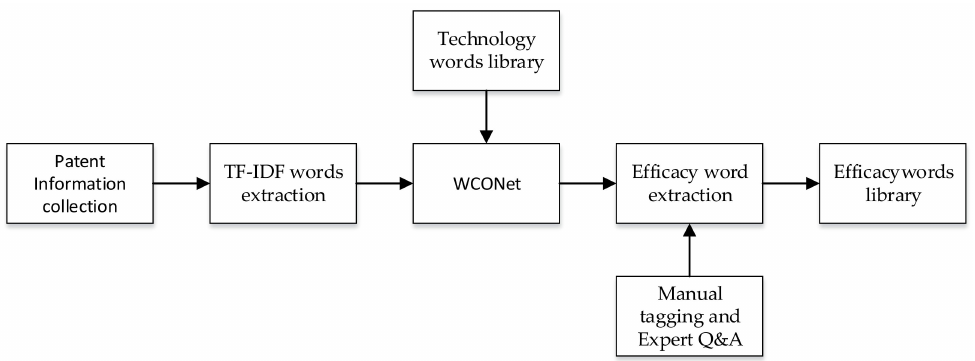
Figure 5. Construction process of the domain’s efficacy